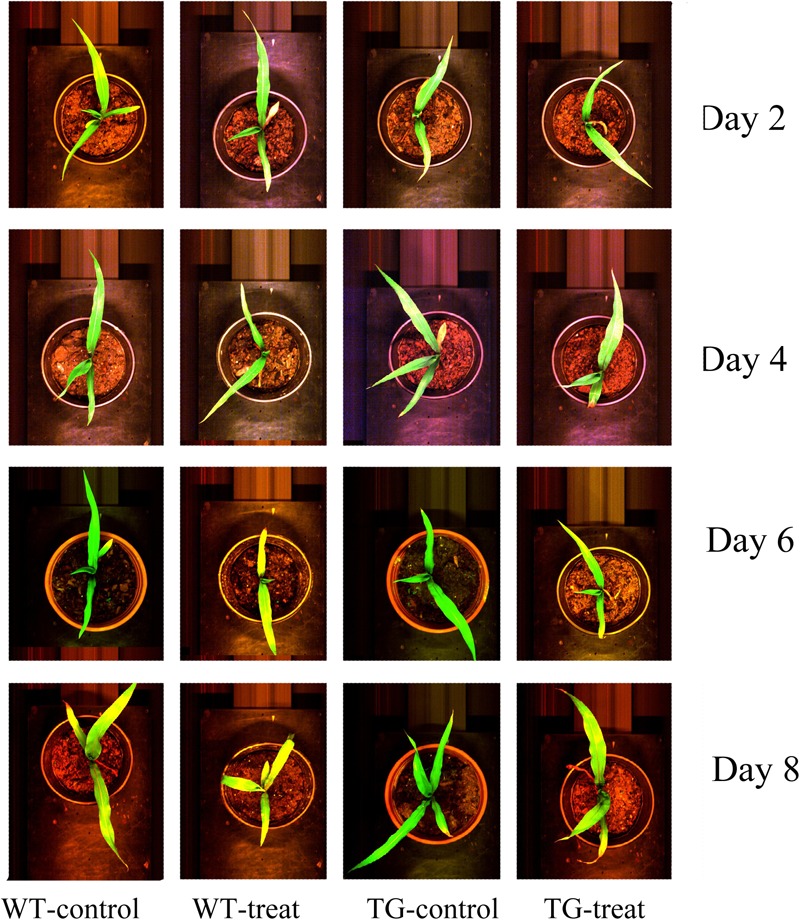
Phenotype of wild-type (WT) and transgenic (TG) maize sprayed with glyphosate after 2, 4, 6, and 8 days, compared with the corresponding control ones (in their original RGB color format).